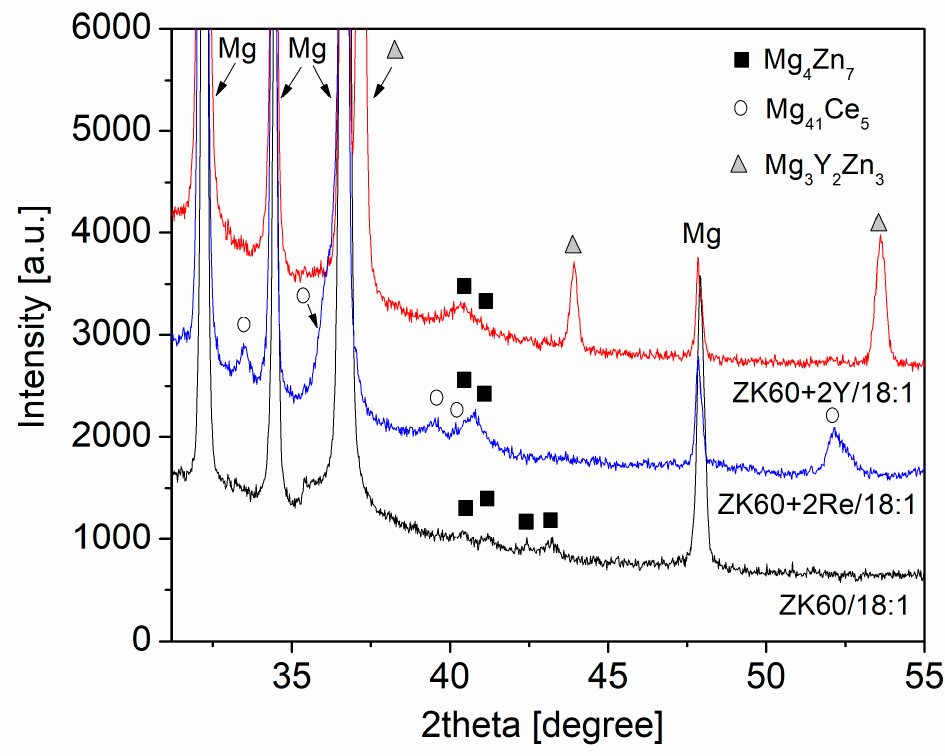
Figure 3. A part of the XRD pa tt erns for the studied alloys.